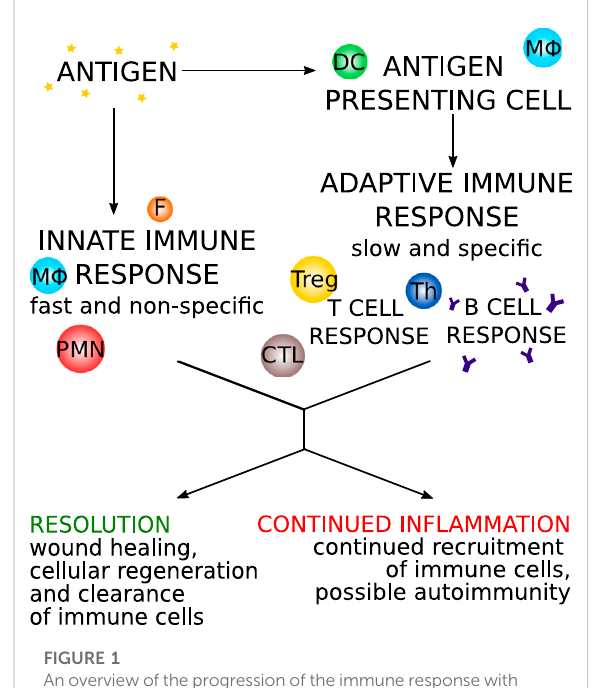
FIGURE 1 An overview of the progression of the immune response with two main arms: the innate response and the adaptive response. DC: dendritic cells, M Φ : macrophages/monocytes, PMN: polymorphonuclear leukocytes, F: fi broblast, Th: T helper cell, Treg: T regulatory cell, CTL: cytotoxic T